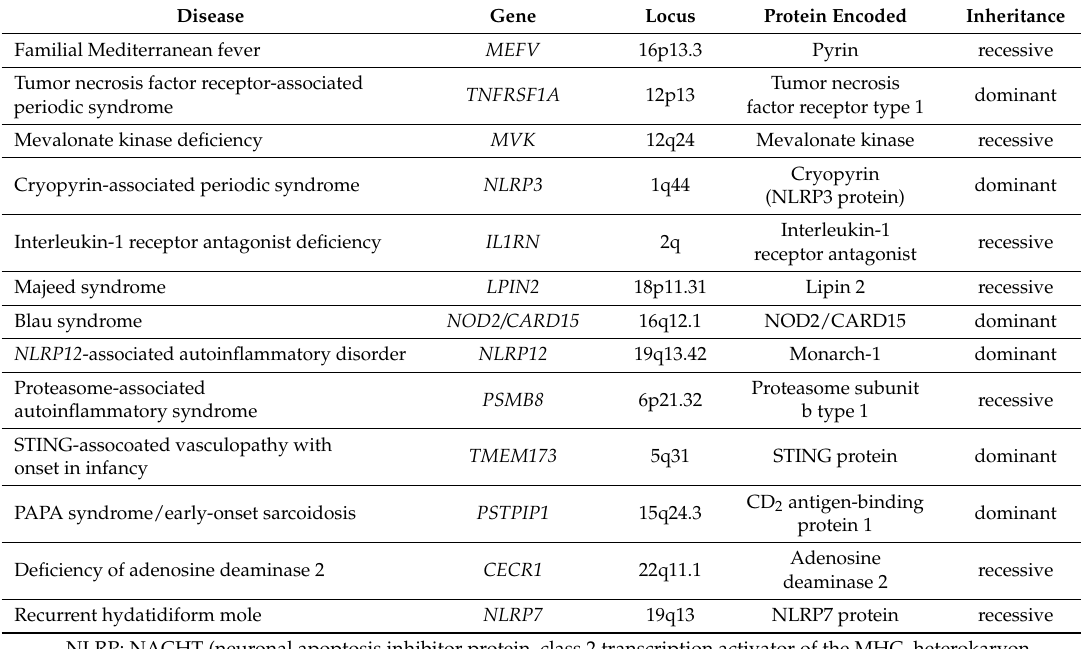
Table 1. Genetic characterization of the hereditary autoinflammatory disorders with their pattern of